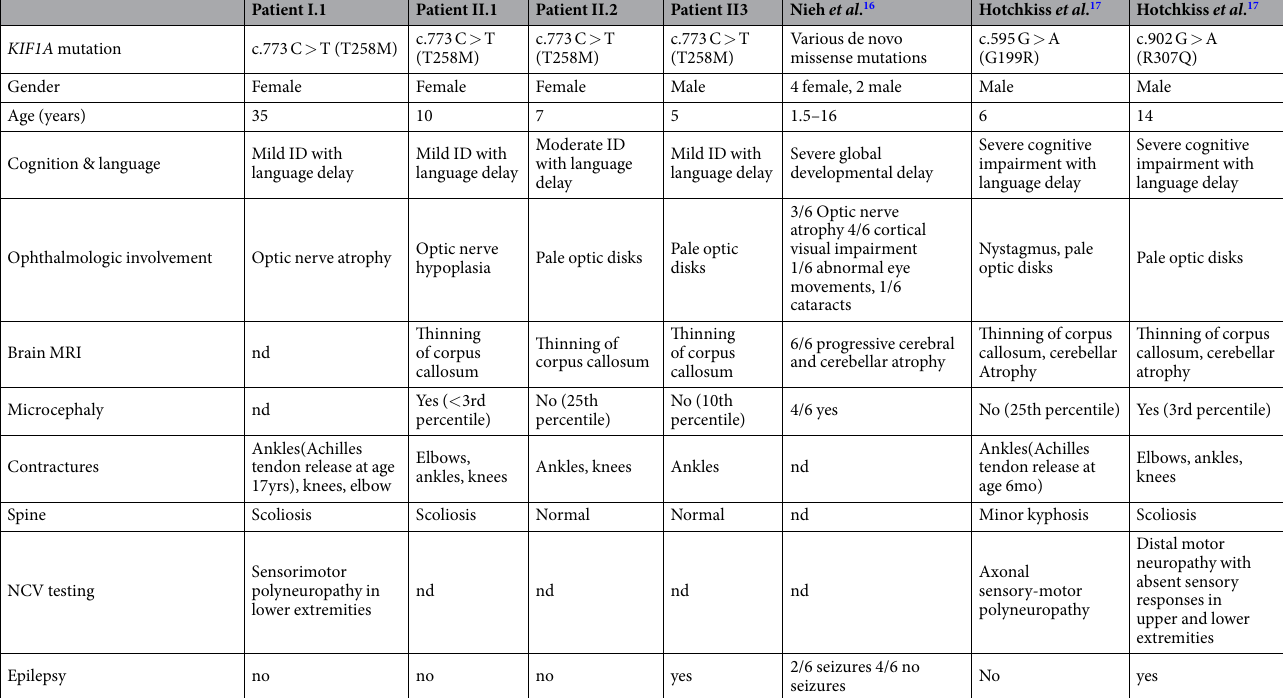
Table 1. Clinical manifestations of patients with KIF1A variant enrolled in this study as well as a summary of clinical characteristics in the three previous reports of patients with de novo KIF1A mutations. nd, not done.